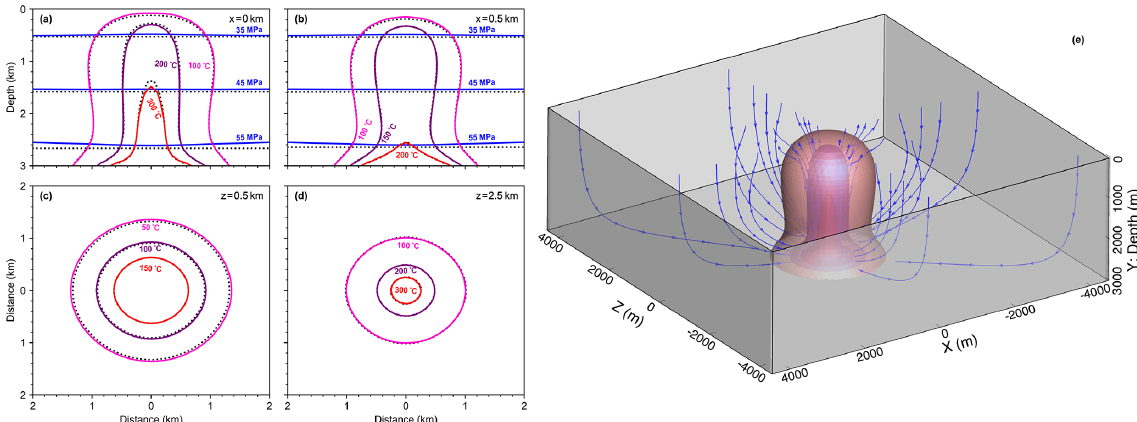
Figure 8. Snapshots of three-dimensional model results. Contour lines for fluid pressure (blue) and temperature calculated from Hydrother- malFoam are plotted as solid lines, and those from HYDROTHERM are plotted as dotted black lines. Panels (a) and (b) show pressure and temperature contours on vertical slices, and panels (c) and (d) show temperature contours on horizontal slices. Panel (e) shows three- dimensional isothermal surfaces and stream lines.